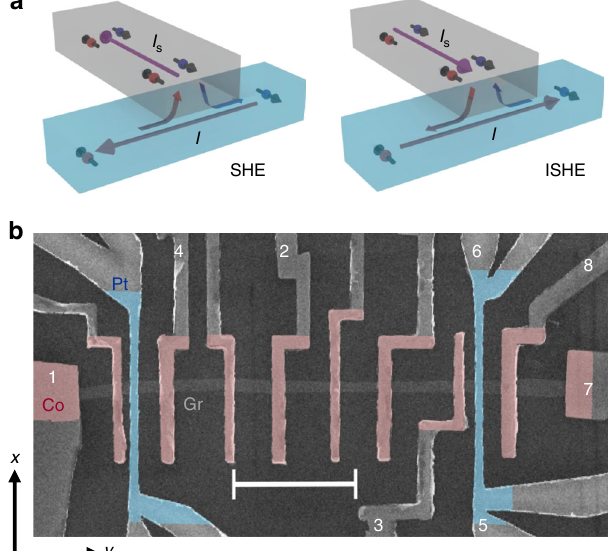
Fig. 1 Illustration of the spin absorption method and scanning electron microscope (SEM) image of the device. a Sketches of spin injection ( left ) and detection ( right ) using the SHE and ISHE, respectively, with the spin absorption technique, in which a pure spin current I S is vertically transferred between a non-magnetic spin transport channel ( grey ) and a metal with strong SOC ( blue ). b SEM image of a graphene-based spintronic device. It consists of standard LSVs with ferromagnetic Co electrodes with TiO 2 barrier ( red color ) placed adjacent to each other. This electrode con fi guration allows the study of the spin transport properties of graphene ( grey color ) using standard FM electrodes (see Fig. 2a for details). In addition, Pt wires ( blue color ) are placed in between two pairs of Co electrodes. This extra con fi guration allows the study of spin absorption by Pt (see Fig. 3a for details) and spin current injection (via SHE) and detection (via ISHE) using Pt (see Fig. 4a for details). Scale bar is 3 μ